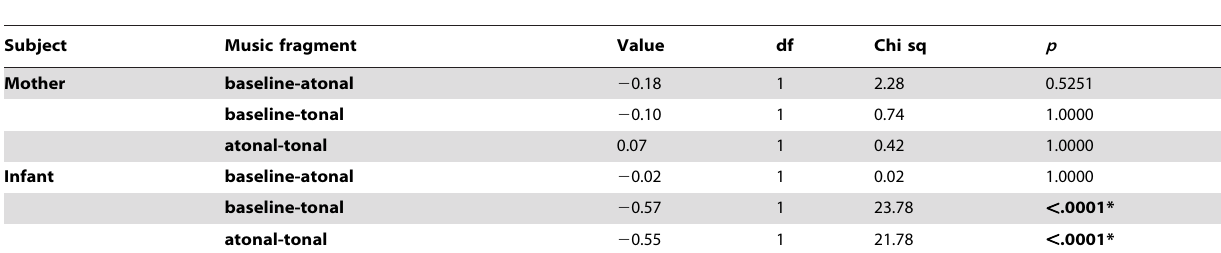
Table 2. Post hoc comparisons for the mothers and infants for the effect of the tonal/atonal music on the corrected